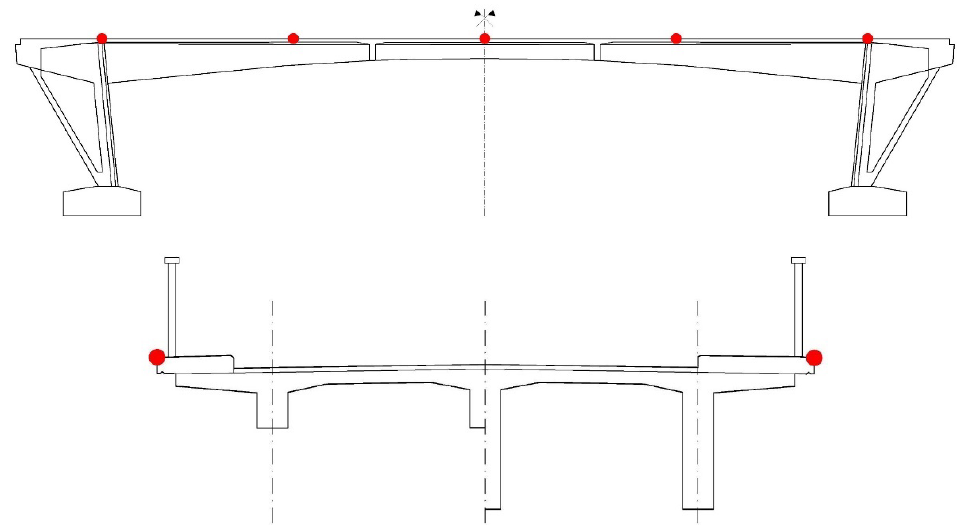
Figure 11. Position of monitoring points for Geodetic Surveying.